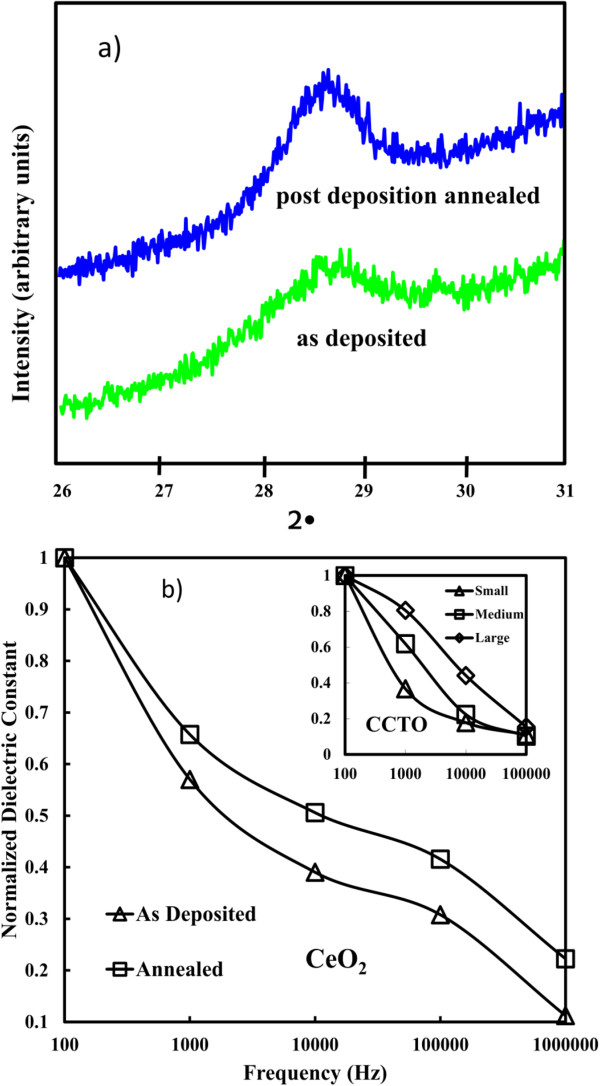
XRD of (a) and normalized dielectric constants (b) for as-deposited and annealed CeO2samples. (b) Under different frequencies [57].